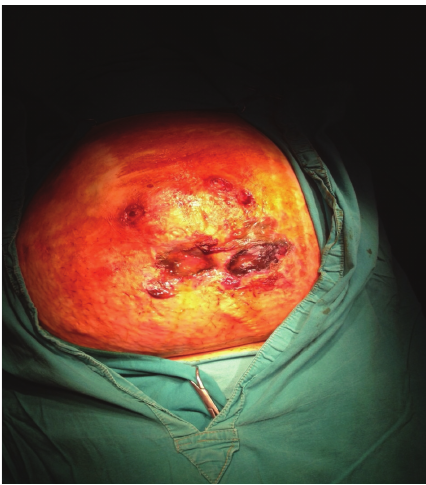
Figure 1: Preoperative photo of the patient.